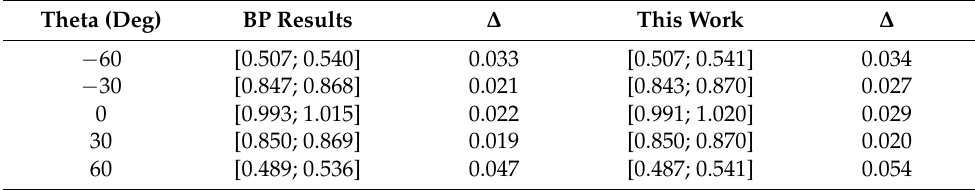
Figure 9. Interval pattern of E-plane element factor. Table 1. Interval value of element factor of plane E in Figure 9.